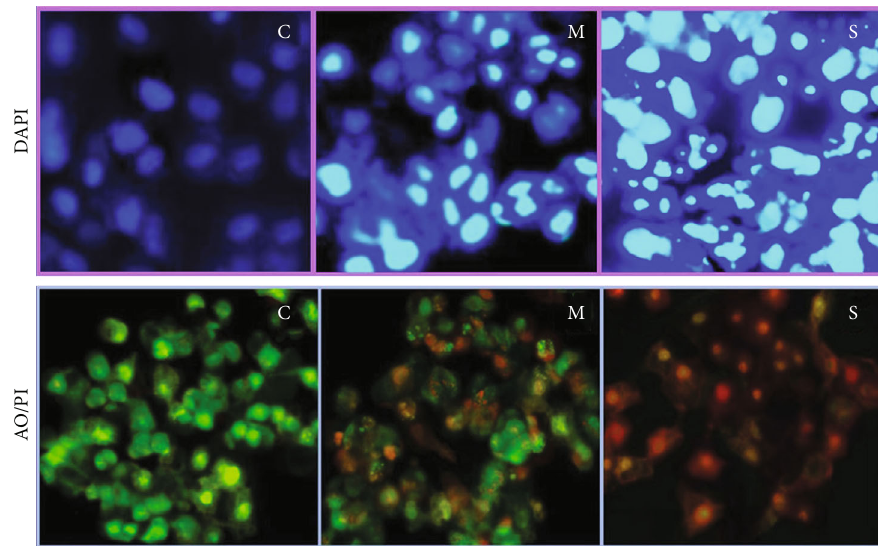
Figure 5: Fluorescent microscopic imaging of HeLa cancerous cells, stained with DAPI stain or acridine orange/propidium iodide (AO/PI) double staining, after treatment with 500 μ g/mL from bee venom/fungal chitosan nanoparticles ∗ . ∗ C: control (untreated) cells; M: treated cells for 24 h; S: treated cells for 48